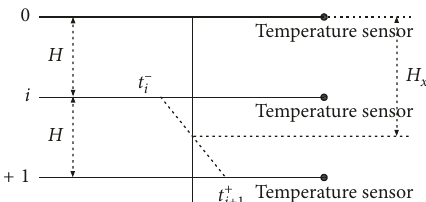
Figure 2: Schematic diagram of frozen depth calculation.